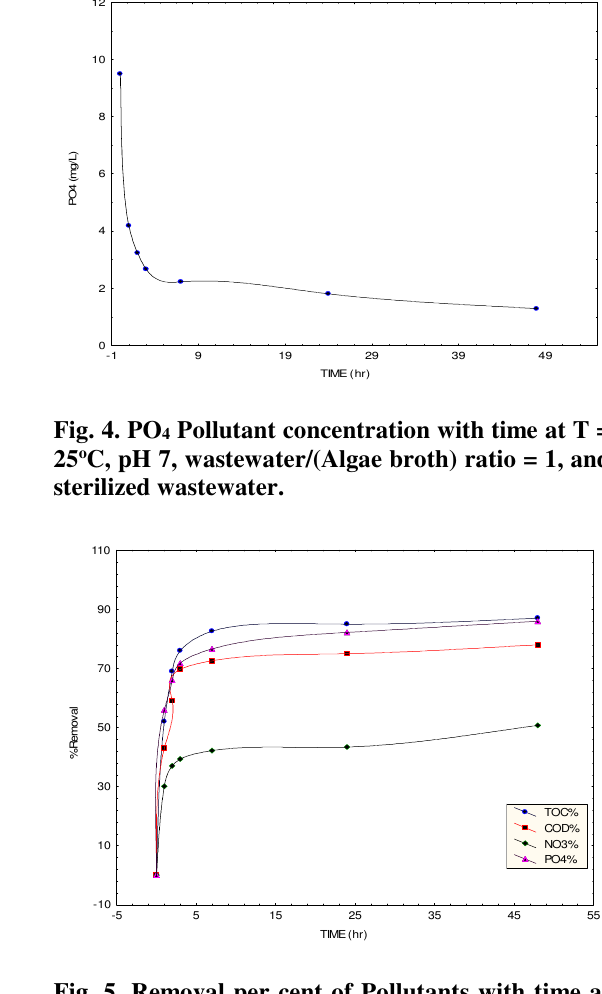
Fig. 5. Removal per cent of Pollutants with time at T = 25 o C, pH 7, wastewater/(Algae broth) ratio = 1, and sterilized